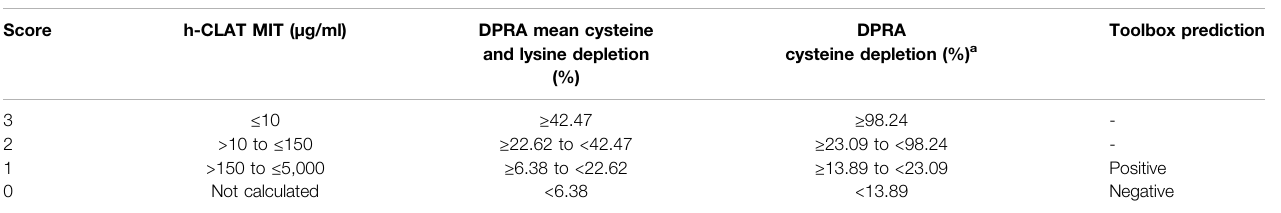
TABLE 2 | ITSv2 scoring system for individual information sources.